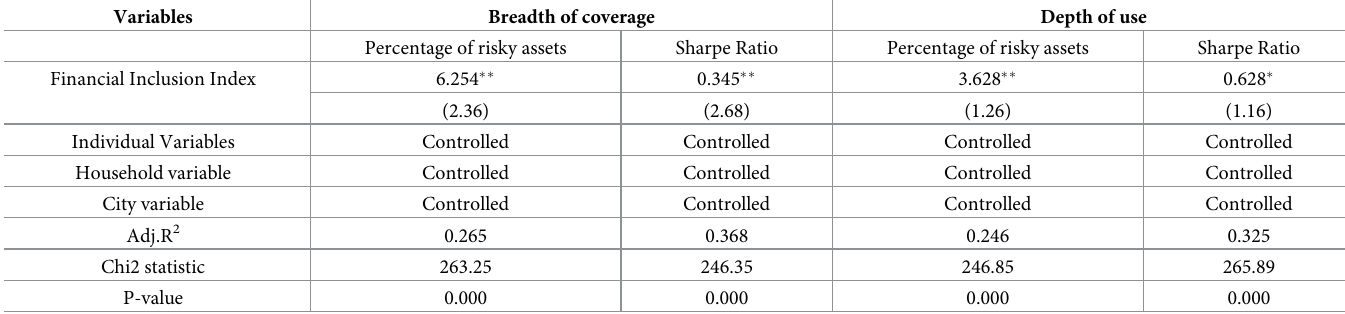
Table 7. Robustness tests considering differences between urban and rural residents.